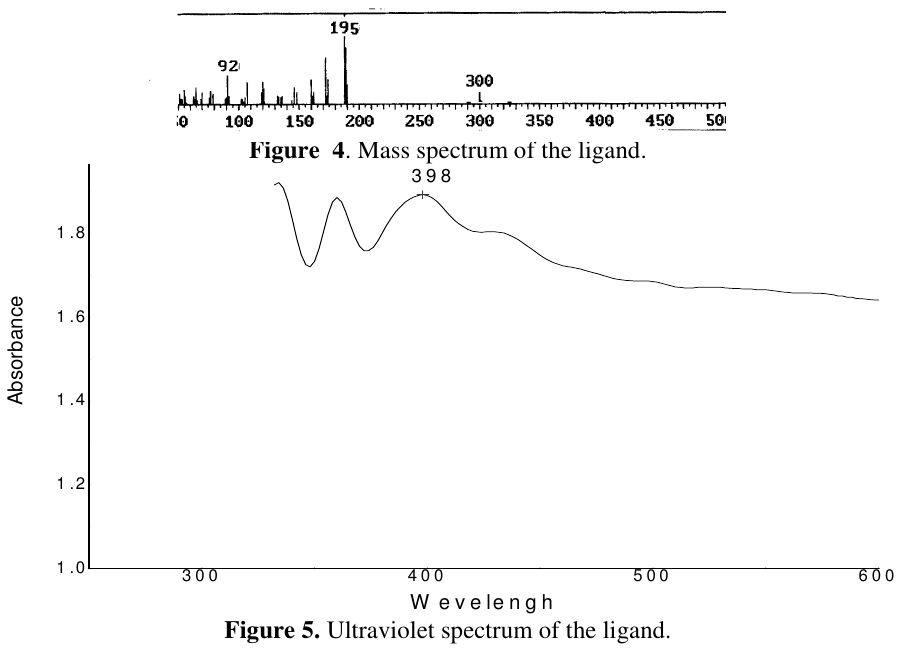
Figure 5. Ultraviolet spectrum of the